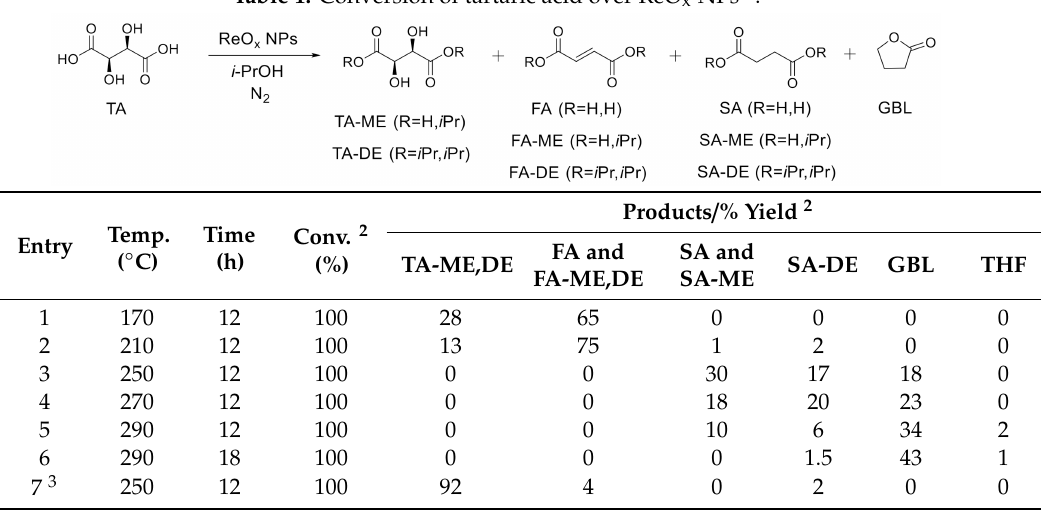
Table 1. Conversion of tartaric acid over ReO x NPs 1 .